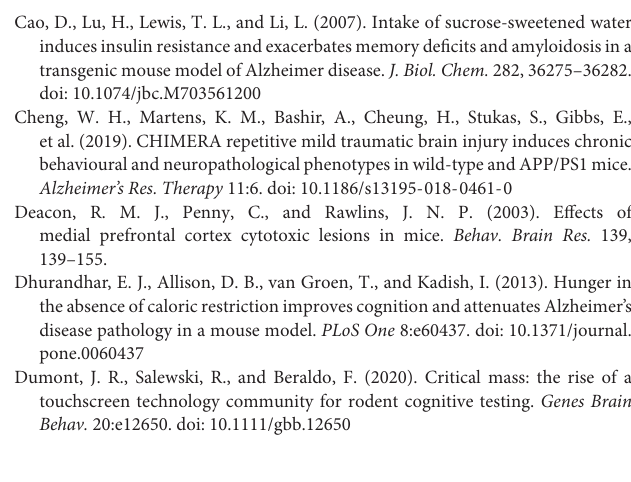
Supplementary Figure 2 | APP/PS1 mice show no differences in Stage 2 training in TUNL at 10 or 15 months of age. (a) Genotype had no effect on accuracy over TUNL stage 2 training in 10-month-old mice or (b) 15-month-old mice. (c) Odds of correct selection was unaffected by day and genotype but increased by separation level in 10-month-old mice and (d) and increased by day and separation level in 15-month-old mice. (e) Genotype had no effect on the number of correction trials performed over the two separation levels of TUNL stage 2 training in 10-month-old mice or (f) 15-month-old mice. (g) There was no effect of genotype on the incidence rate ratio of correction trials with 10-month-old mice or (h) 15-month-old mice, while as day and separation level increased, the incidence rate ratio of correction trials decreased in both ages. (a,b) Is presented as group mean ± SEM over 18 days of training. (e,f) Are presented as mean ± SEM with individual animals as dots. (c,d,g,h) Are the effect size ± 95% CI, showing the effect of genotype, day and separation level on odds of correct selection and incidence rate ratio of correction trials. ∗ p < 0.05; ∗∗∗ p < 0.001; ∗∗∗∗ p < 0.0001. Supplementary Figure 3 | Touchscreen-tested mice swim more quickly and show a stronger target quadrant preference than their standard housed counterparts in the MWM. (a) Both WT and APP/PS1 touchscreen-trained mice showed a higher swimming velocity in the MWM training across all days excepting day 3 and 6. (b) All groups showed a preference for the target quadrant during the MWM probe trial, with both WT and APP/PS1 touchscreen-trained groups showing a stronger preference than their standard-housed, behaviorally naïve counterparts. (c) All groups showed a strong preference for the novel arm during a discrete trial forced alternation task. (d) Neither genotype nor prior touchscreen exposure altered the odds of selecting the novel arm during discrete trial forced alternation. (a) Is presented as group mean ± SEM over 7 days of training. (b,c) Are presented as mean ± SEM with individual animals as dots. (d) Is the effect size ± 95% CI, showing the effect of genotype and prior touchscreen exposure on odds of novel arm selection. Dotted line in (b,c) represents chance performance (50%). ∗ p < 0.05; ∗∗∗∗ p < 0.0001. Supplementary Figure 4 | High numbers of proliferating cells and immature neurons are not maintained in mice rested after completing touchscreen testing. (a) Total Ki67 counts are elevated following touchscreen training (TS) in both WT and APP/PS1 mice compared to standard housed (SH) animals, but this effect is lost when animals are rested (R) for 5 months following touchscreen training. (b) Total DCX counts are elevated following touchscreen training in both WT and APP/PS1 mice compared to SH animals, but this effect is lost when animals are rested for 5 months following touchscreen training. (c) Representative images of Ki67 DAB staining in WT and APP/PS1 mice that were SH, underwent TS training or were R following touchscreen training. (d) Representative images of DCX DAB staining in WT and APP/PS1 mice that were SH, underwent TS training or were R following touchscreen training. (a,b) Are presented as mean ± SEM with individual animals as dots. ∗∗∗∗ p <